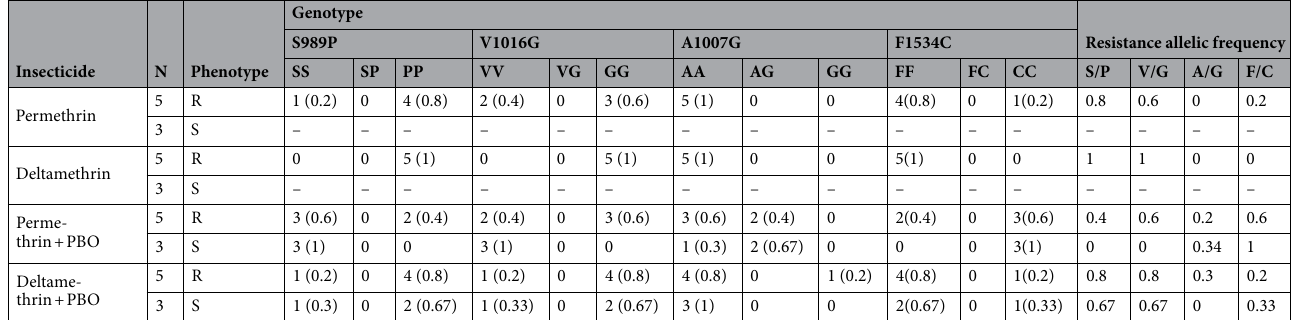
Table 3. Frequencies of S989P, V1016G, A1007G and F1534C substitution in parental of the VSGC gene in Aedes aegypti Selangor